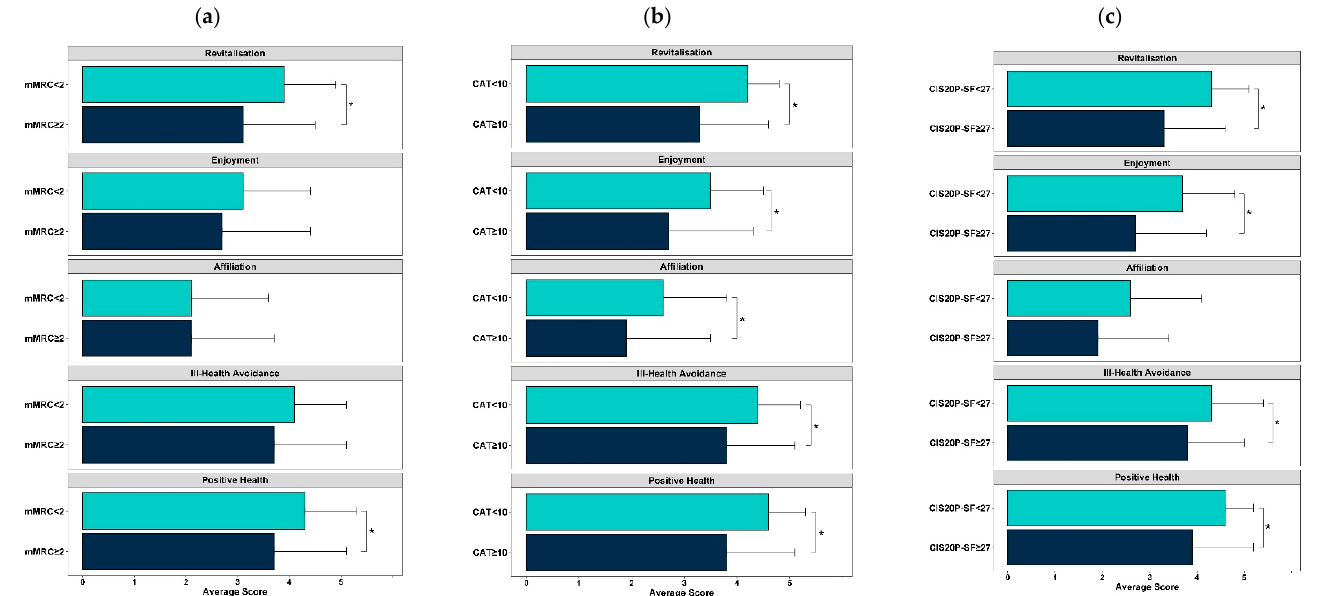
Figure 2. Motivational factors of the Exercise Motivation Inventory-2 (EMI-2) among the symptoms using the COPD Assessment Test (CAT), modified Medical Research Council Dyspnoea Scale (mMRC) and Checklist of Individual Strength— Subjective Fatigue (CIS20-SF) (* p < 0.05). ( a ) mMRC. ( b ) CAT. ( c ) CIS20-SF.